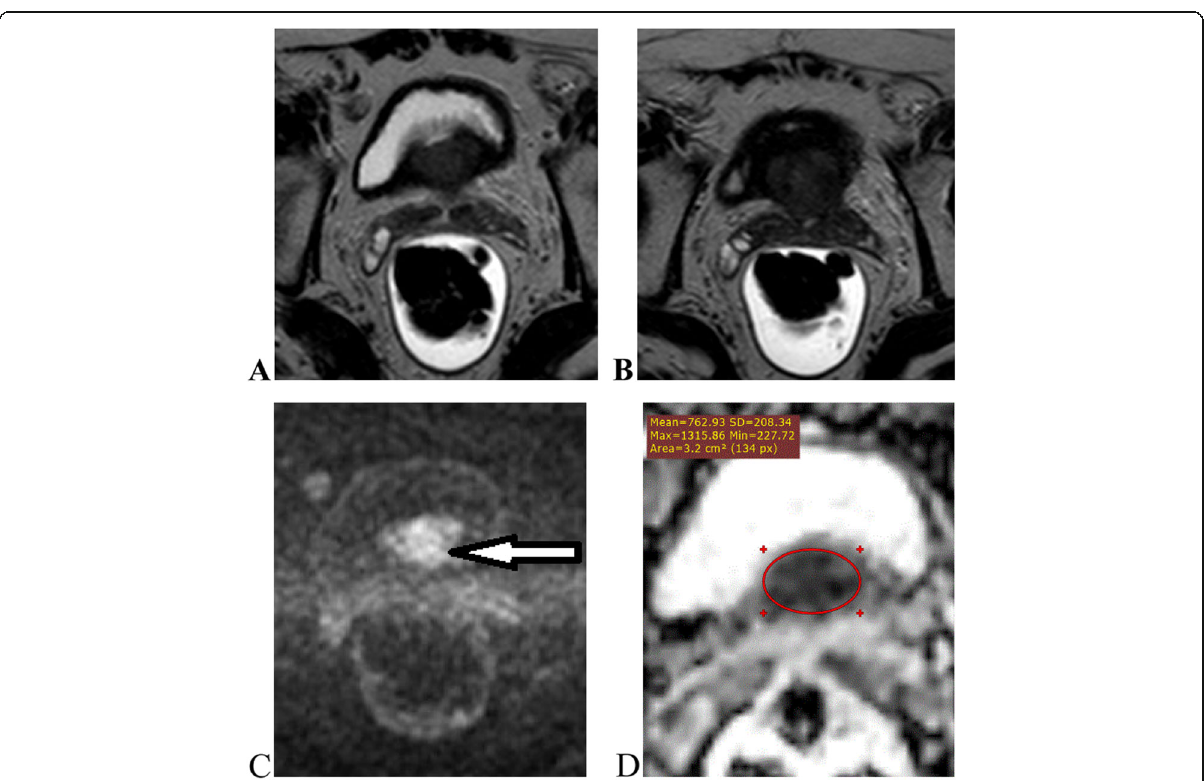
Fig. 4 A 78-year-old man with total PSA 83 with concordant interpretation in terms of PIRADSv2 DWI score. a , b Axial T2W with a central zone isointense signal intensity lesion that was not well identified on T2W images but protruding into bladder. c DWI (at b value 800) showing marked bright signal intensity of the lesion 1.5 cm. d ADC map image showing marked low signal of the lesion with mean ADC value 0.762. The qualitative DWI score was 4 for readers 1 and 2. The ADC ratio between benign prostatic tissues was 1.67. Histopathology was Adenocarcinoma GS 4 + 4 = 7; tumor volume = 1.2 cm 3 ;